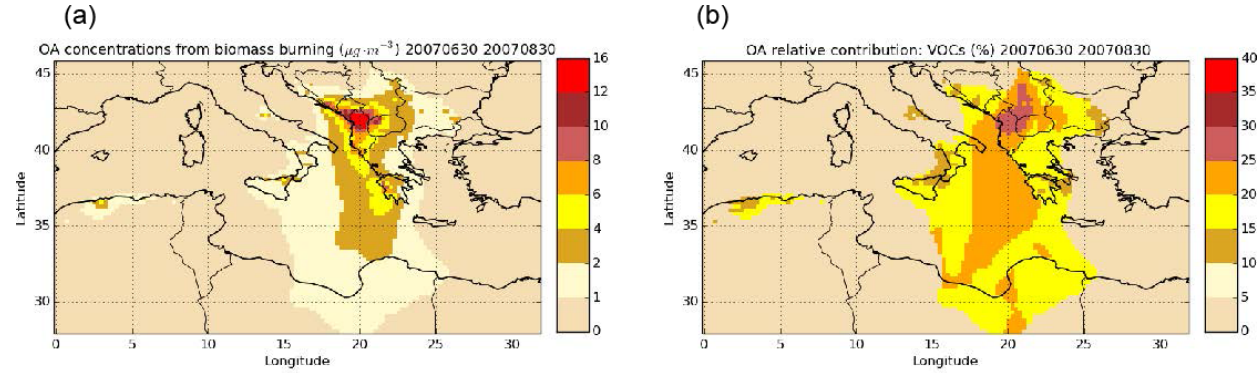
Figure 11. Daily mean surface OA concentrations from wildfires (a) and the relative contribution of VOCs (%) to OA from wildfires (b) during the summer of 2007 (simulation Multstep-withVOC).